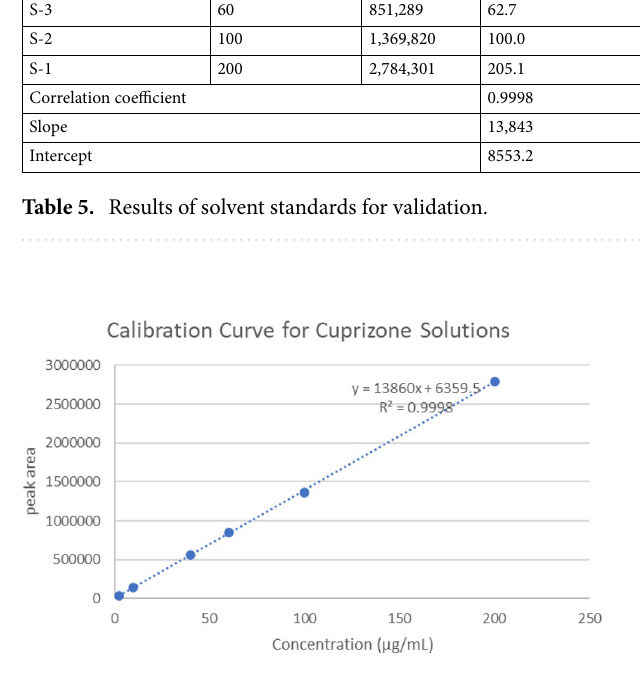
Figure 8. Calibration curve for cuprizone solutions.